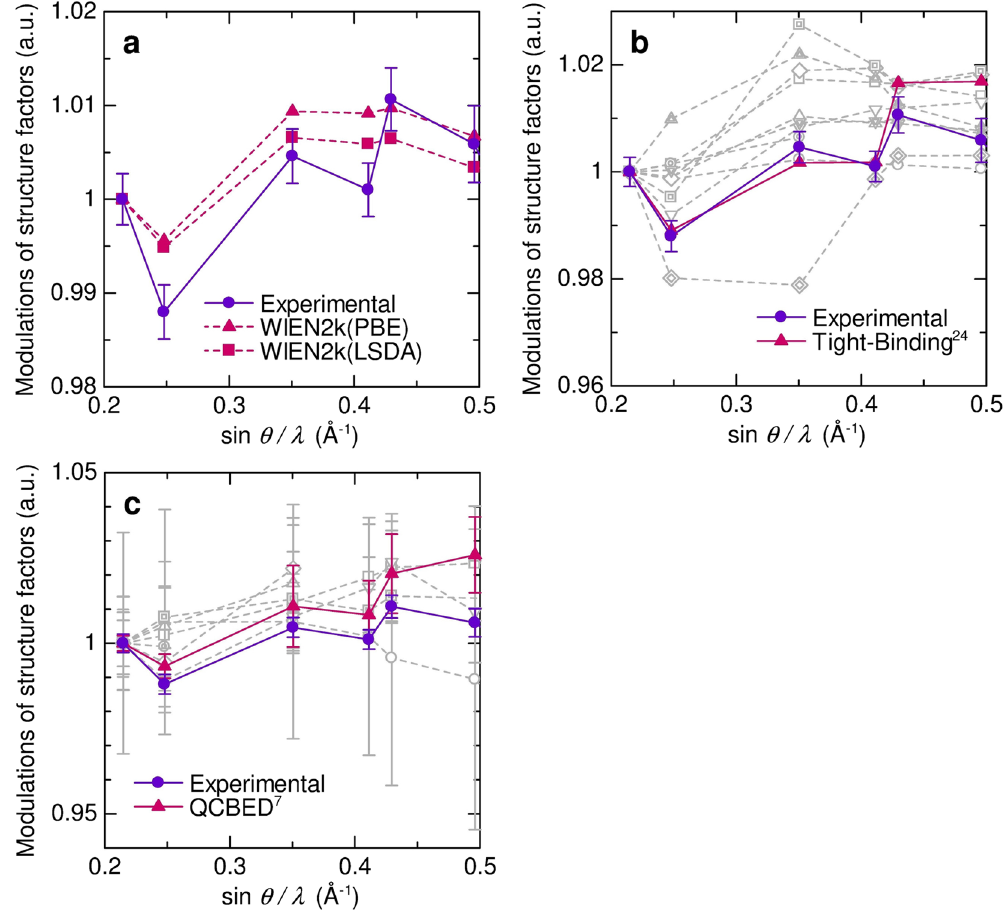
Figure 1. Relative ratio of structure factors to IAM normalized by 111 reflection. Horizontal axis is reciprocal resolution sin θ / λ . ( a ) The present experimental and theoretical values. ( b ) Reported theoretical values and the present experimental values. Gray lines, which represent the reported theoretical values in refs 15–24 , show no agreement with the present experimental values. ( c ) Reported experimental values and the present experimental values. Gray lines have no significant deviation from 111.